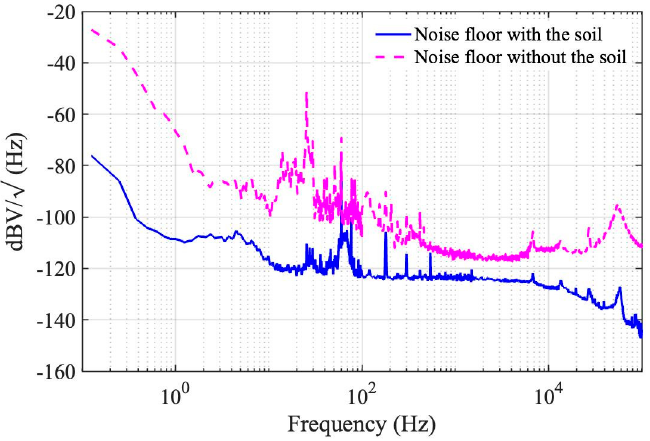
Figure 4. The noise spectra of the MZ − FP interferometer over a six − decade frequency span (0.1 Hz − 100 kHz) with (solid) and without (dashed) the soil insulation. (0.1 Hz–100 kHz) with (solid) and without (dashed) the soil